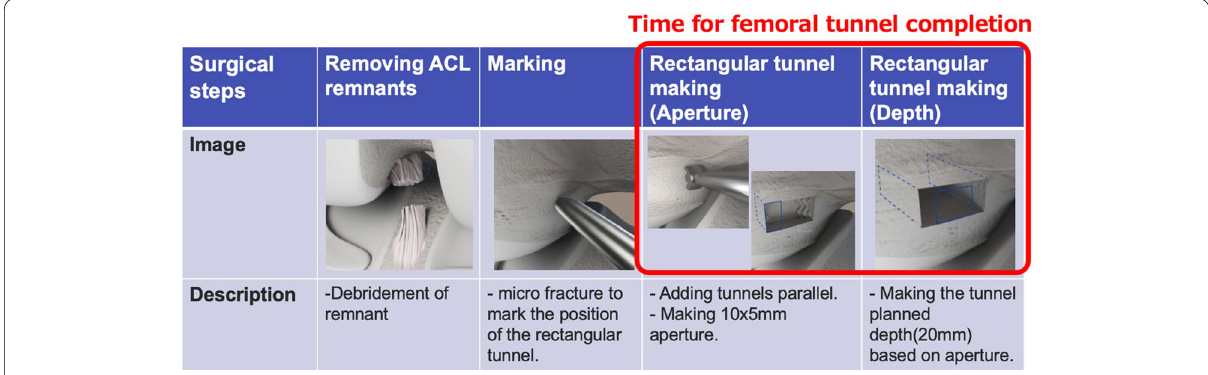
Fig. 3 Surgical steps and time for femoral tunnel